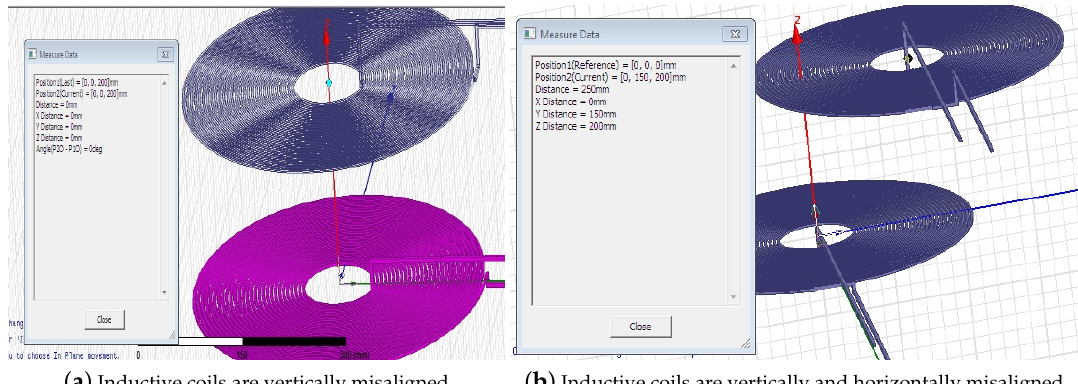
Figure 6. Misalignment of inductive coils under numerical